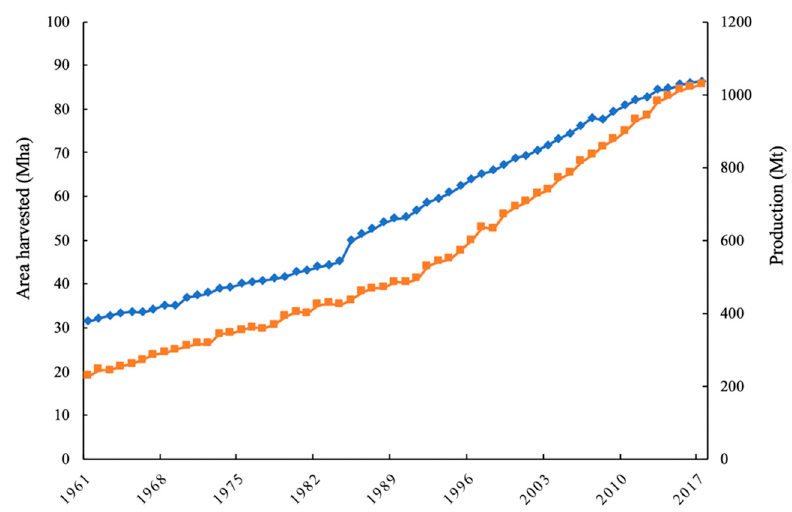
Figure 1. Total world area harvested (blue) and production (orange) of tree crops during the period 1961–2017 [1].